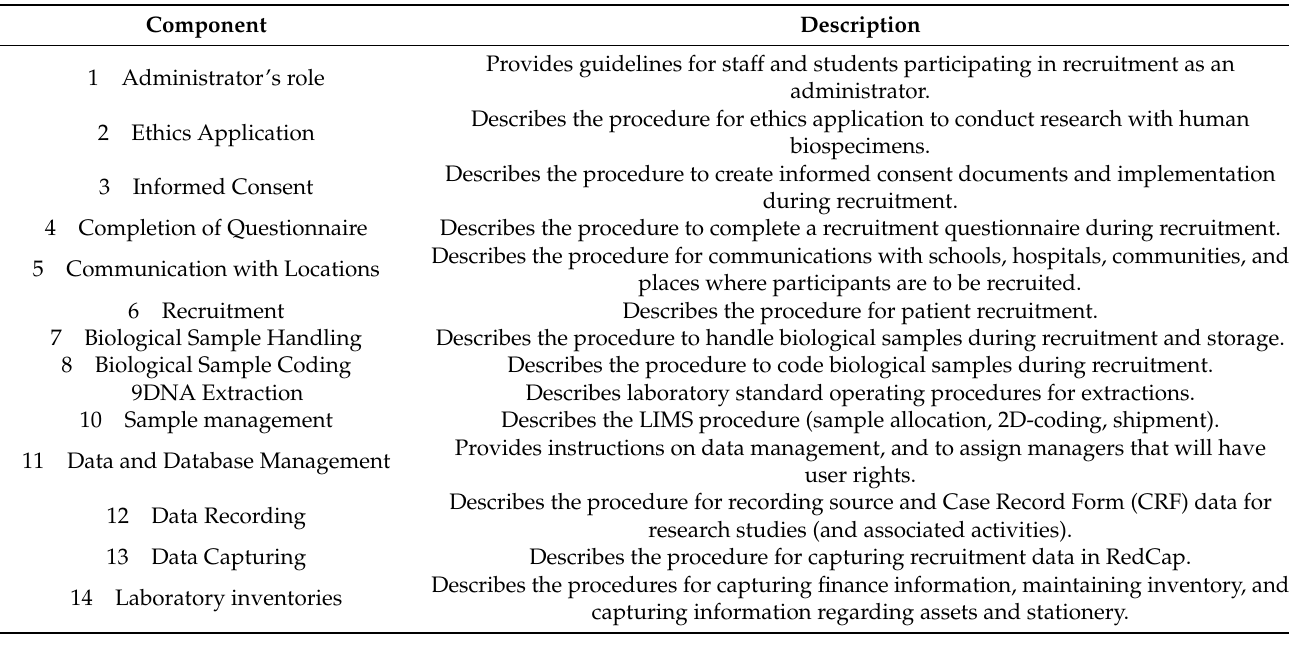
Figure 1. ( a ) Overview of LIMS design development phase. ( b ) The overview of the implementation phase of LIMS across study sites coordinated from South Africa. ( c ) The training of the staff team on LIM, labeling and barcoding of sample, Baobab storage layout.